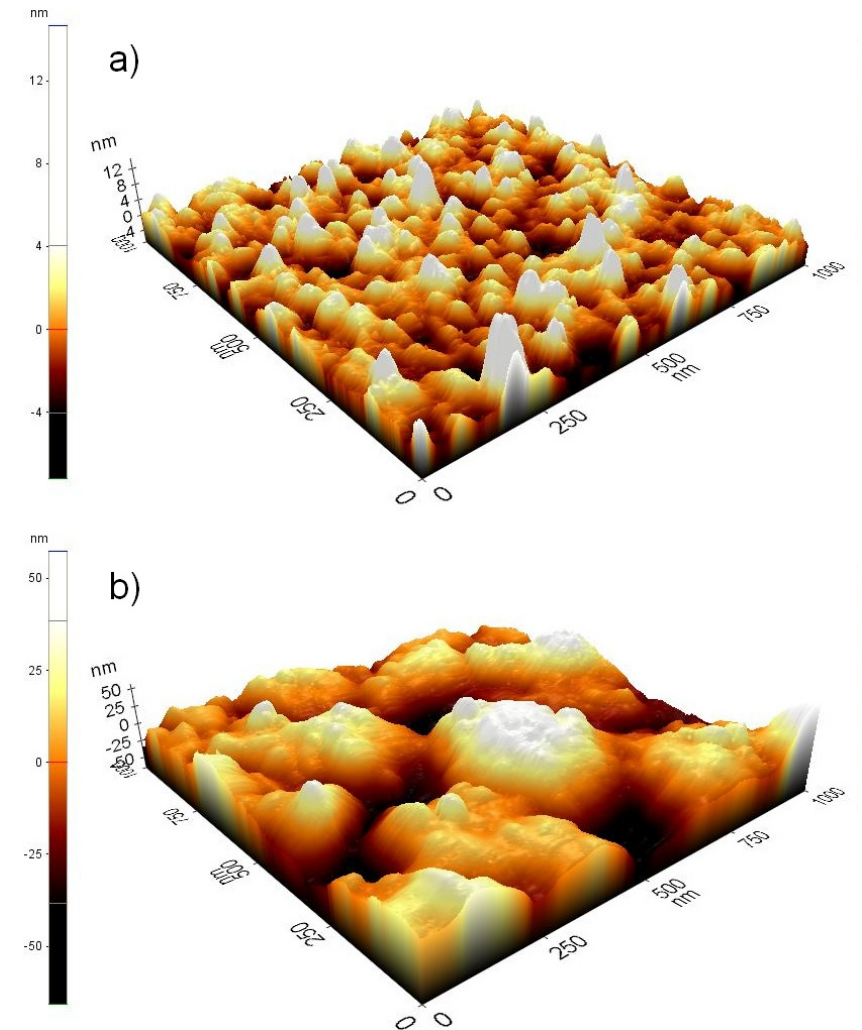
Figure 3. AFM images from (a) all-titanium microelectrode of tMEA and (b) TiN coated microelectrode surface of cMEA. Note the different vertical z-axis